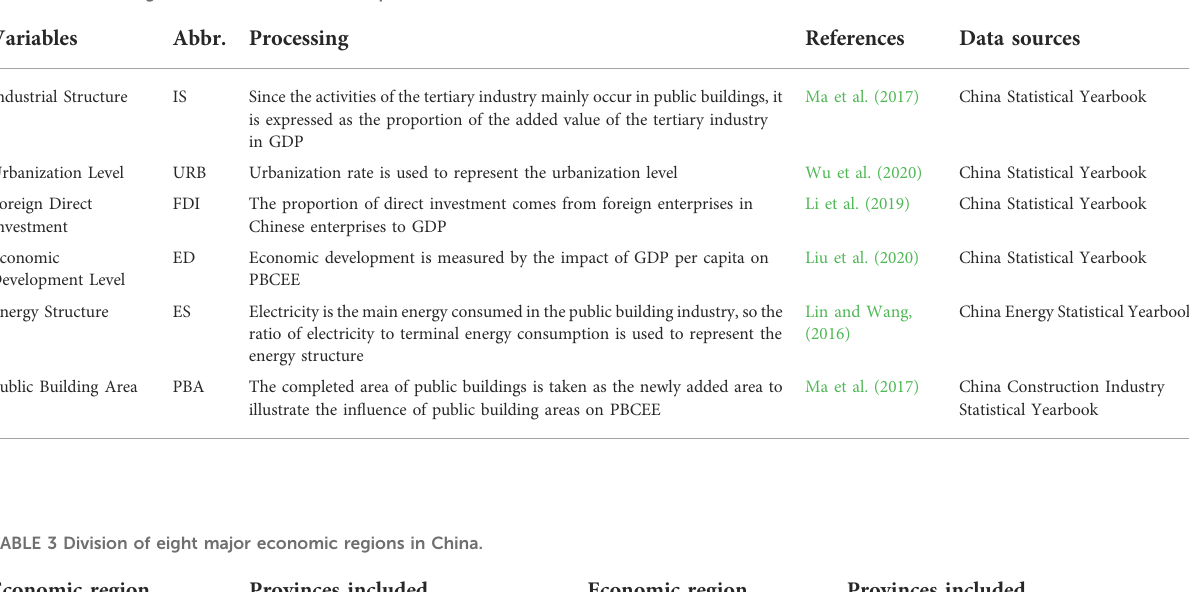
TABLE 3 Division of eight major economic regions in China. Economic